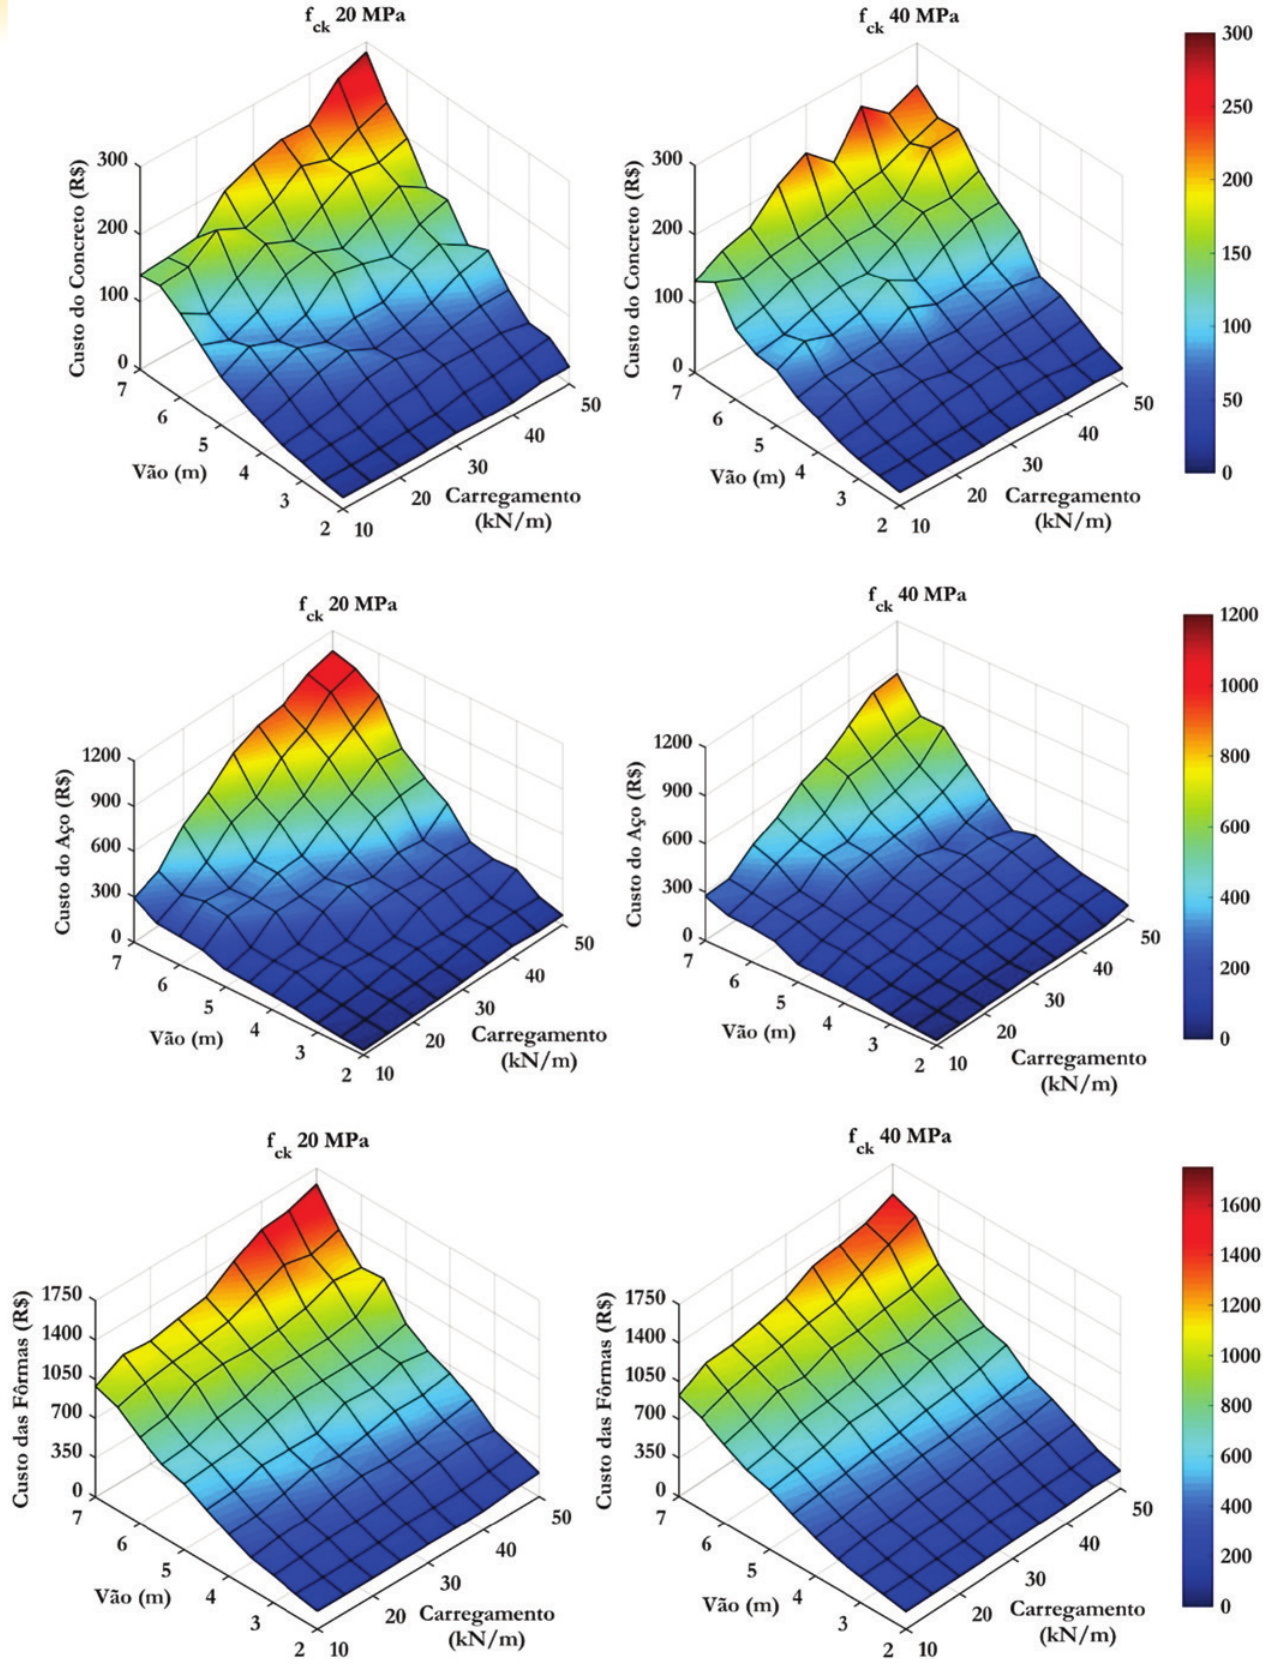
Figura 9 Custos (R$) dos materiais (concreto, aço e fôrmas) nas seções otimizadas, para concretos de 20 MPa e 40